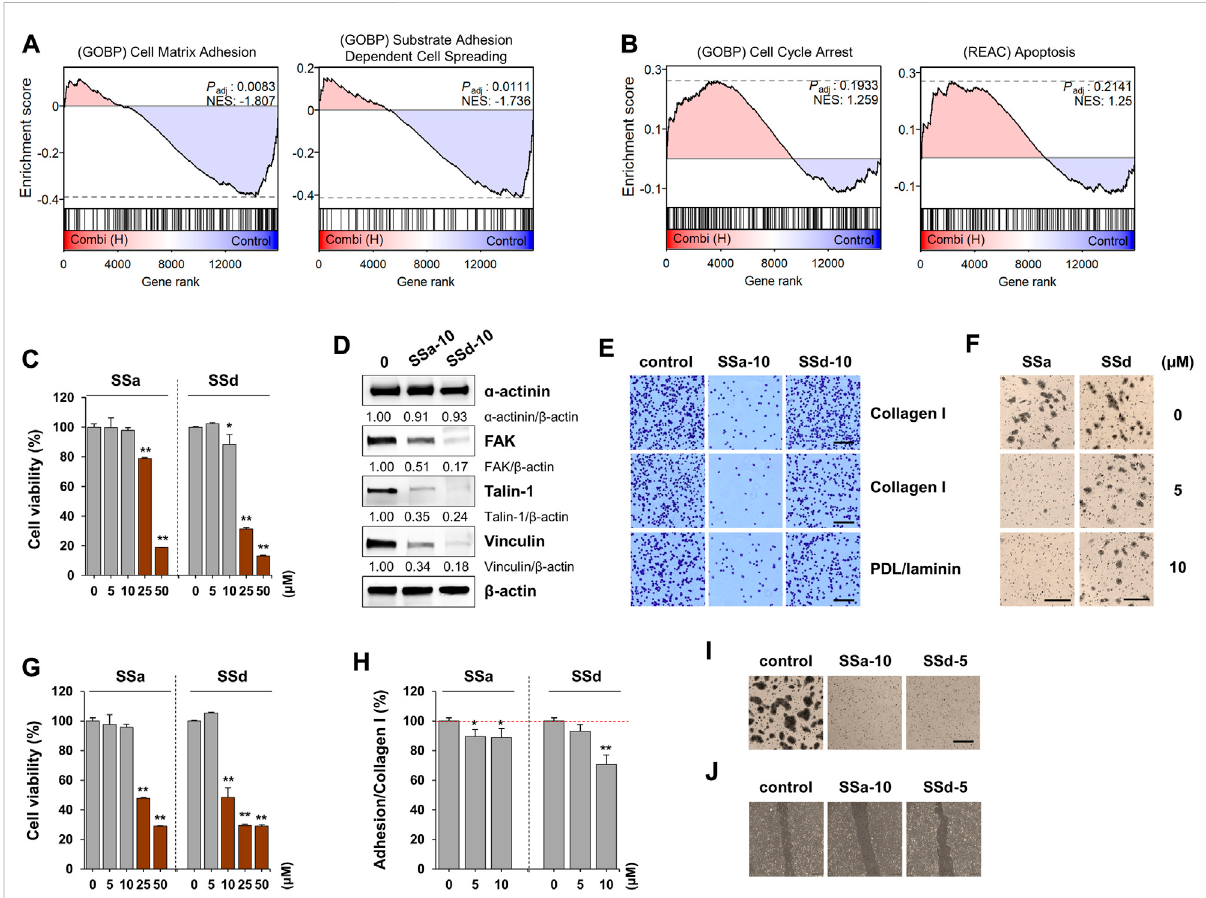
FIGURE 5 Effectsofsaikosaponin(SS)onproliferation,adhesion,andmigrationofA549andHaCaTcells. (A,B) Genesetenrichmentanalysisresultsforthe combination of SSs with (A) decreased and (B) increased pathways. (C) A549 cells seeded on 96-well culture plates were treated with SSa or SSd (0 – 50 μ M) for 24 h. Cell viability relative to vehicle-treated cells was expressed as the mean ± SD. (D) A549 cells were treated with SSa (10 μ M) and SSd (10 μ M) for 24 h, and the protein levels of ɑ -actinin, focal adhesion kinase, talin-1, and vinculin were measured by immunoblotting. After normalization to β -actin expression, the relative band intensities were calculated. Data are representative of two independent experiments. (E) A549 cells were treated with SSa (10 μ M) and SSd (10 μ M) for 24 h. After harvesting the cells, adhesion to collagen I, collagen IV, or poly-D-Lysine/ laminin was observed after crystal violet staining. Scale bar = 100 μ m. Original magni fi cation × 100. (F) A549 cells treated with 5 and 10 μ M SSa and SSd were harvested, and their transwell migration was measured. Scale bar = 200 μ m. Original magni fi cation × 100. (G) HaCaT cells were treated with SSa and SSd (0 – 50 μ M) for 24 h and the cell viability relative to vehicle-treated cells was expressed as the mean ± SD of triplicate samples. (H) AdhesiontocollatedImatrixwasdeterminedinSSa-andSSd-treatedHaCaTcells,anddataareexpressedasthemeans±SDoftriplicatesamples. (I) HaCaT cells treated with 10 μ M SSa and 5 μ M SSd were harvested, and their transwell migration was measured. Scale bar = 200 μ m. Original magni fi cation×100. (J) InjurylinesweremadeonHaCaTcellsgrown upto90%con fl